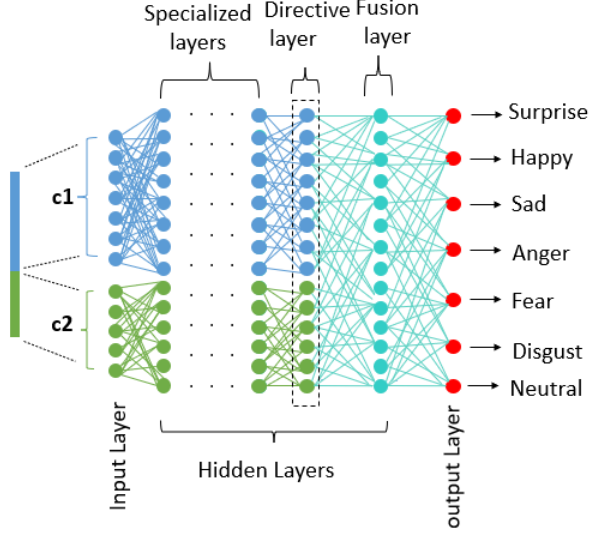
Figure 3. General architecture of meaningful neural network.